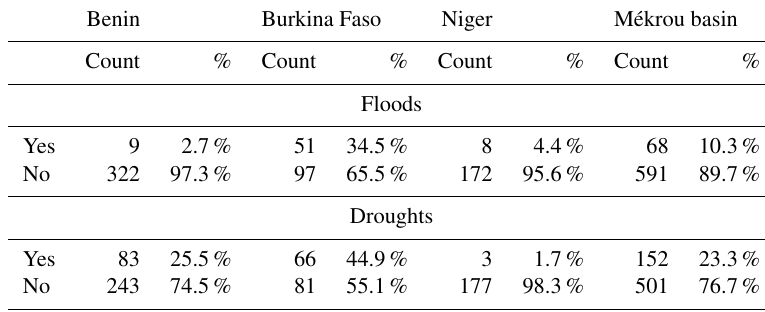
Table 7. Experienced extreme flood events during the last 2 years (2014–2015).